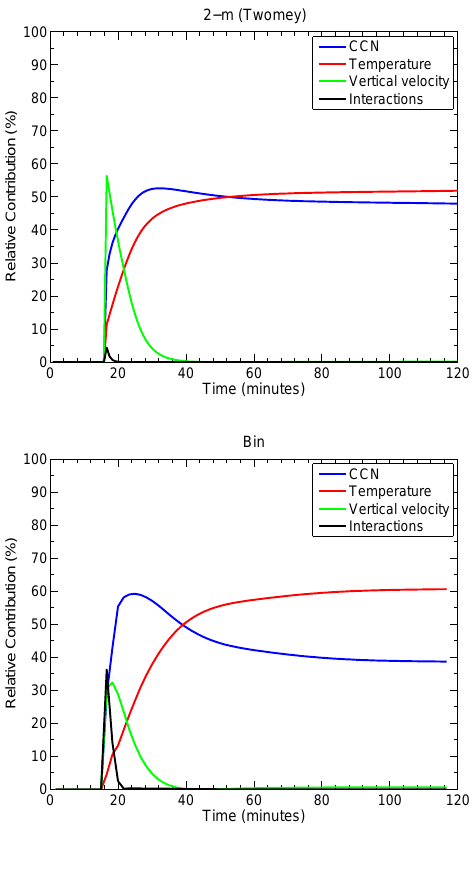
Fig. 10. As for Fig. 9 but for an increase in w 1 from 2ms − 1 to 4ms − 1